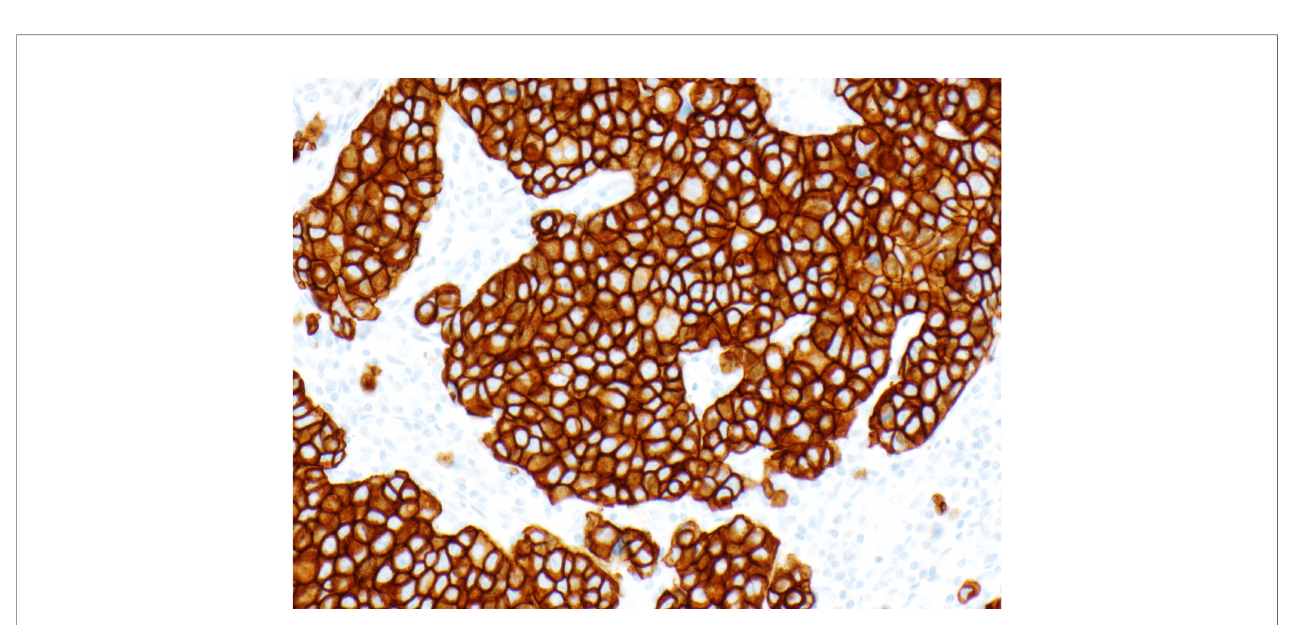
FIGURE 2 | Breast carcinoma stained with HercepTest ™ , IHC3+ score.